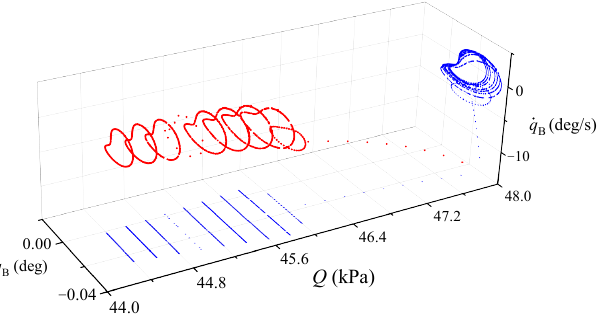
Figure 12. Poincaré section variation with dynamic pressure at δ B / δ T = 0.01. The sampling interval is 0.2 kPa.